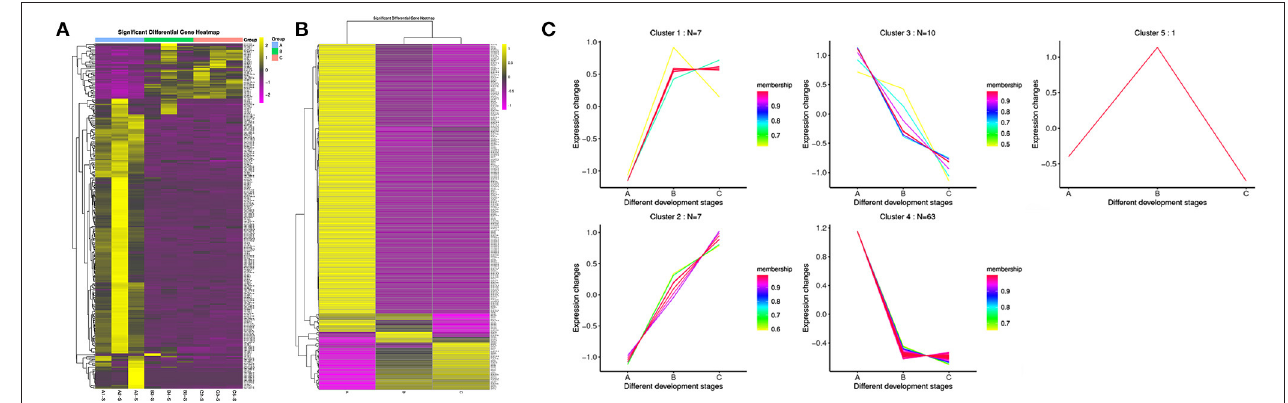
FIGURE 2 | Clustering pattern of DE miRNAs. (A) Clustering pattern of DE miRNAs between different samples. A1, A2, A3 were the samples for 1-month-old kids (group A), B3, B4, B5 were the samples for 12-month-old maiden goats (group B), C2, C3, C5 were the samples for 24-month-old adult goats (group C). (B) Clustering pattern of DE miRNAs between different groups. A were the samples group A, B were the samples for group B, C were the samples for group C. (C) Trends of medium and above expression of DE miRNAs. Cluster 1 shows the DE miRNAs that lowly expressed in group A and highly expressed in group B and C. Cluster 2 shows the DE miRNAs that gradually increased in group A, B and C. Cluster 3 shows the DE miRNAs that gradually decreased in group A, B, and C. Cluster 4 shows the DE miRNAs that highly expressed in group A and lowly expressed in group B and C. Cluster 5 shows the DE miRNAs that highly expressed in group B and lowly expressed in group A and